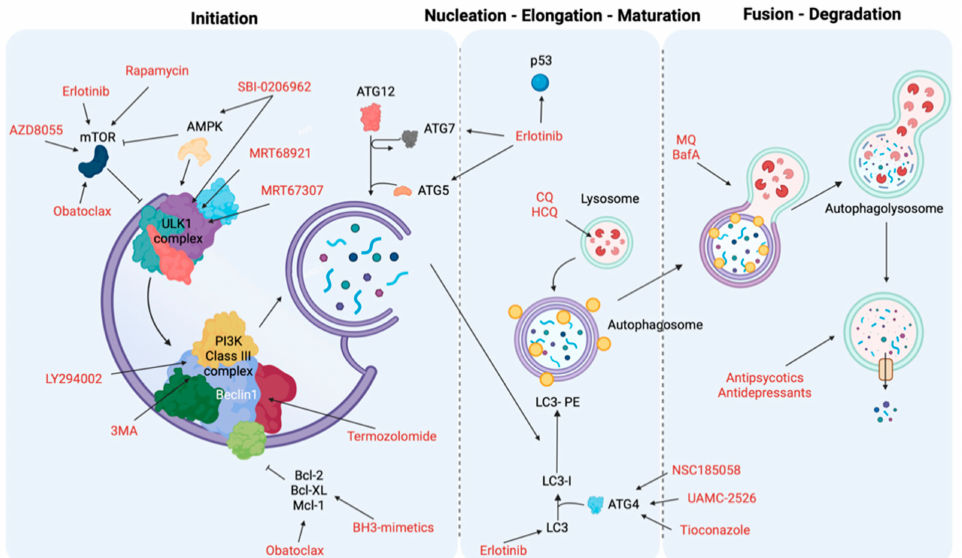
Figure 2. The modulators involved in the phases of autophagy: initiation and nucleation, elongation closure, and vesicle degradation. These factors can positively or negatively regulate autophagy by inhibiting cell growth and tumor progression and inducing of cancer cell death. For a detailed explanation, see the